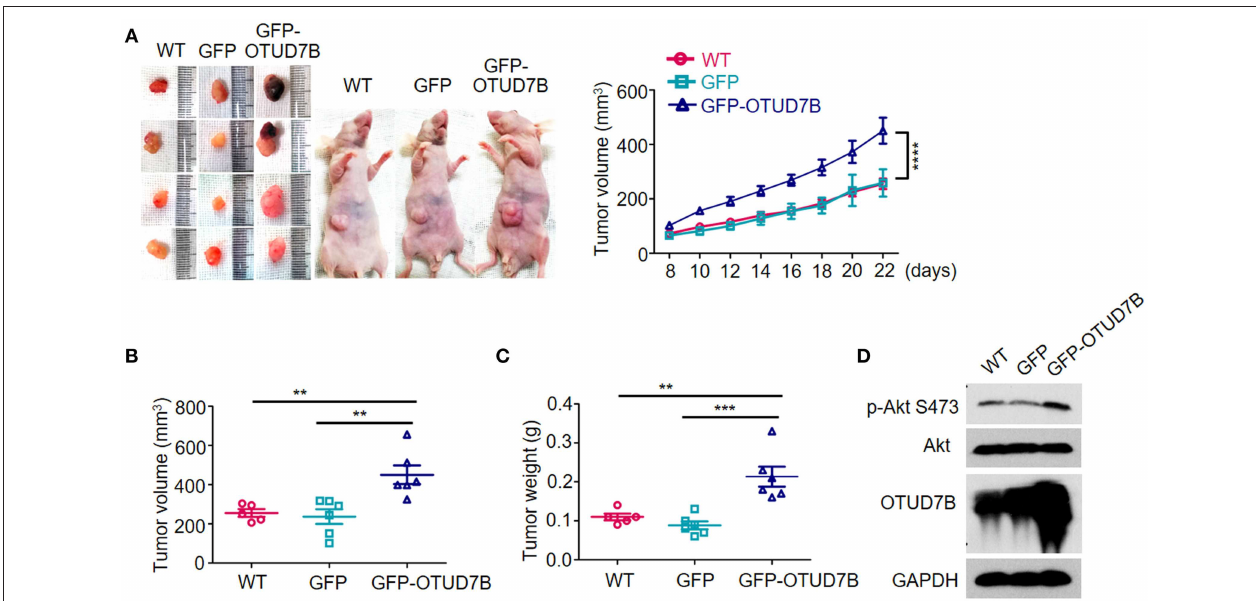
FIGURE 5 | OTUD7B promotes in vivo tumorigenicity of NSCLC via Akt signaling activation. (A) Nude mice were injected s.c. with wild type (WT), GFP- or GFP-OTUD7B-overexpressing NCI-H358 cells at 5 × 10 6 cells per site. Tumor volume was monitored every 2 days after subcutaneous injection and tumor growth curve is shown (right). Tumor volume was calculated by the formula: V = ½ × a (length) × b 2 (width). Tumors were harvested from the mice 22 days after subcutaneous injection and photographed (left). (B,C) The volume (B) and the weight (C) of the harvested tumors was measured. (D) Total lysates of tumor tissues were subjected to immunoblotting using anti-p-Akt and anti-Akt antibodies. Data are shown as mean ± s.e.m. ** P < 0.01, *** P <